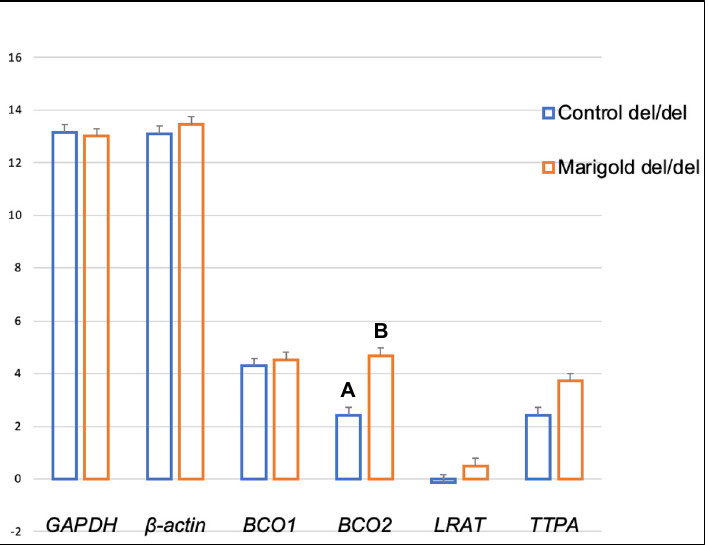
Figure 8. Relative BCO1 , BCO2 , LRAT, and TTPA mRNA levels (log2 abundance) in the brain of rabbits with the del/del genotype at codon 248 of the BCO2 gene, fed different diets (control diet vs. a diet with the addition of Aztec marigold flower extract). GAPDH and ß ‐ actin were used as reference genes. Data represent posterior means (expressed as arbitrary units) ± SEM (standard error of the mean). Means followed by the different superscripts (A, B) differ highly significantly ( p ≤ 0.01). Table 2. Content of selected compounds in the brain ( μ g/g) of rabbits (mean SD). BCO2 genotype and dietary xanthophyll concentrations affected the differentiation of carotenoid and α -tocopherol levels in the rabbits’ brains (Table 2). Animals with the BCO2 del/del genotype were characterized by higher concentrations of these micronutrients than Compound rabbits with ins/ins and ins/del genotypes. Overall, the intergroup relationships were similar to those found in adipose tissue, but the noted differences were smaller.